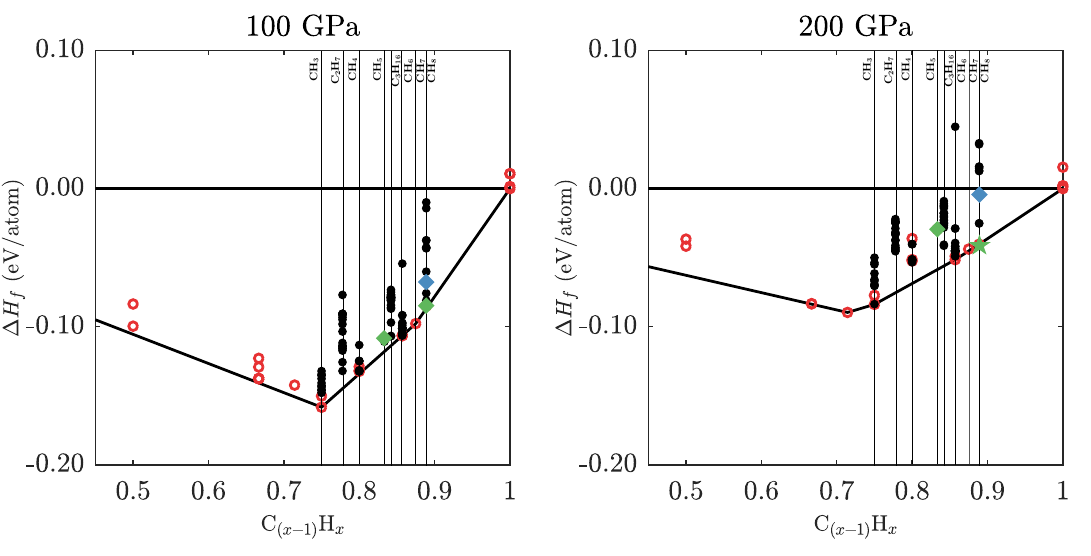
Figure A1. Convex hulls of low enthalpy structures found in the structure searches performed in this work at 100 and 200 GPa (black circles). Red circles denote enthalpies of hydrocarbon structures from the literature. Notable CH 4 (H 2 ) 2 structures P 2 1 / c and the Ar(H 2 ) 2 inspired compound are indicated in green and blue, respectively. Of these, a star symbol indicates thermodynamic